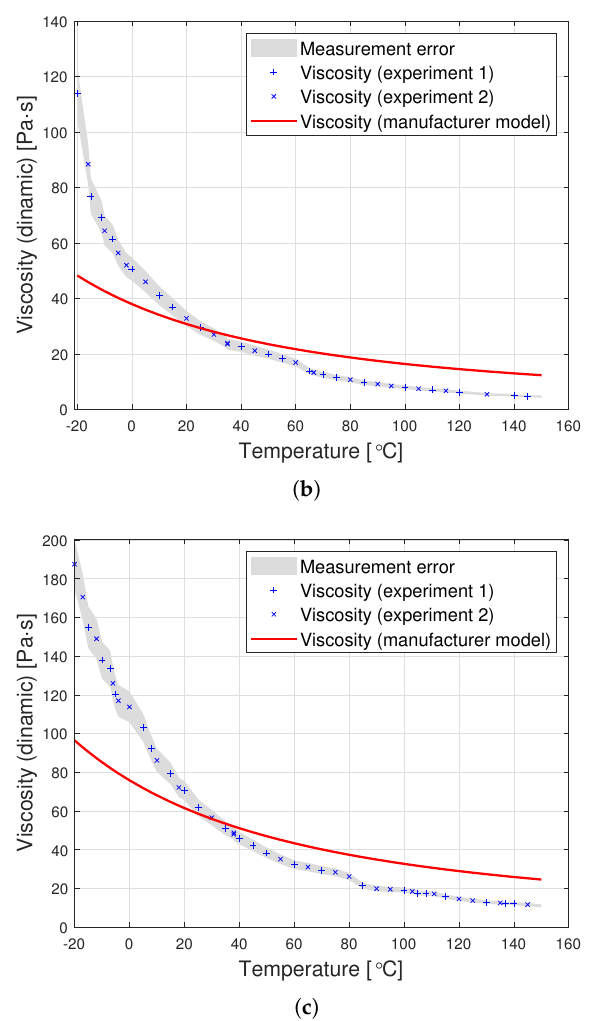
Figure 3. Graphs of PDMS viscosity as a function of temperature for experimental measurements and the producer’s model, for oils with nominal kinematic viscosities: ( a ) 10,000cSt, ( b ) 30,000cSt, ( c )